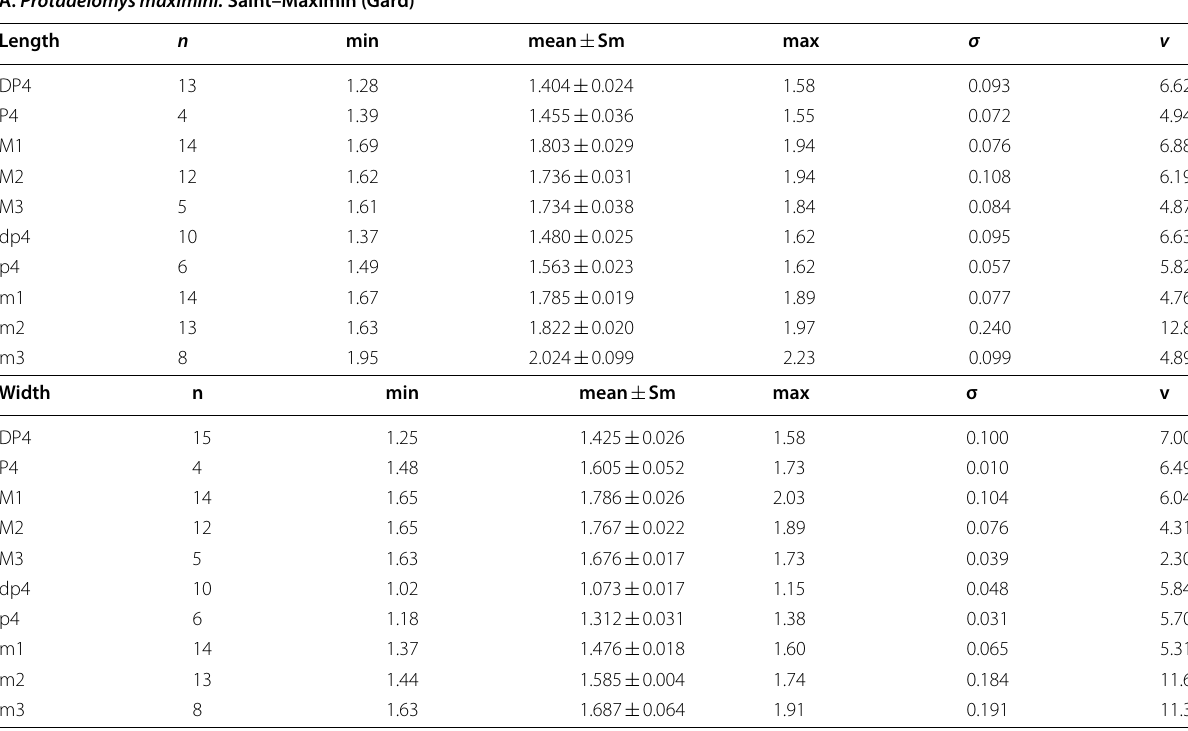
Table 6 Range of the size variations (length and width: min., max.; average loci of teeth of ? Protadelomys maximini Escarguel, 1998 and B. length and width for some loci only of ? Protadelomys cf. maximini nov. sp.1, 2, from Saint Maximin (MP 13?; Gard,